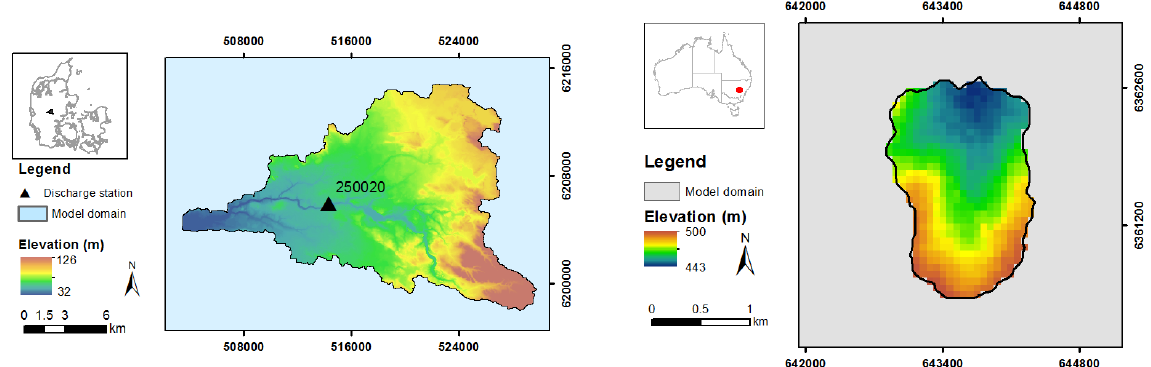
Figure 2. Sub-catchment of the Skjern River basin located in western Denmark (reproduced from Ajami et al., 2014) (left), and the Baldry sub-catchment in Australia (right). Modeling domains are extended beyond the catchment boundary to remove the impact of boundary conditions on catchment